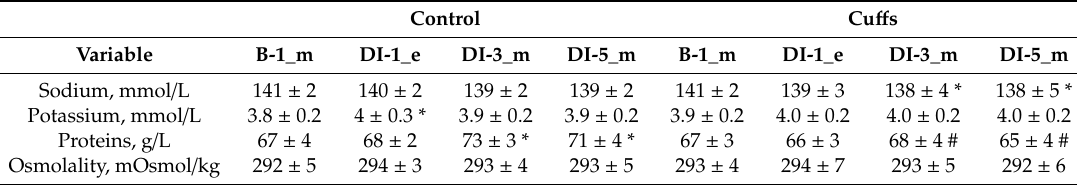
Table 2. Blood Na+, K+, proteins, and osmolality. Values are mean ± SD; * p ≤ 0.05 vs. baseline; # p < 0.05 vs. Control; m—morning; e—evening.